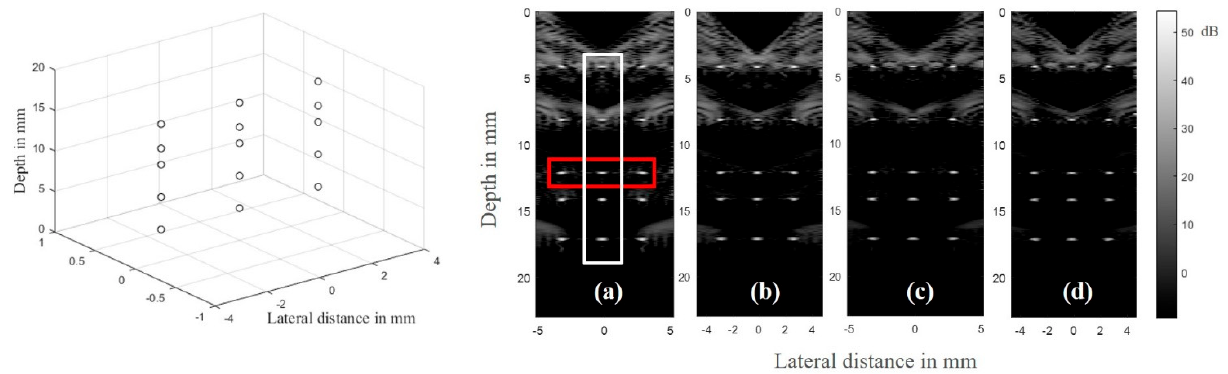
Figure 7. The phantom and comparisons between simulation results of uniform and non-uniform linear arrays at different depths arranged in the order that corresponds to the sound simulation results: ( a ) The result of different depths of the MULA, ( b ) the MNULA with various widths, ( c ) the MNULA with various kerfs, and ( d ) the MNULA with various kerfs and widths.